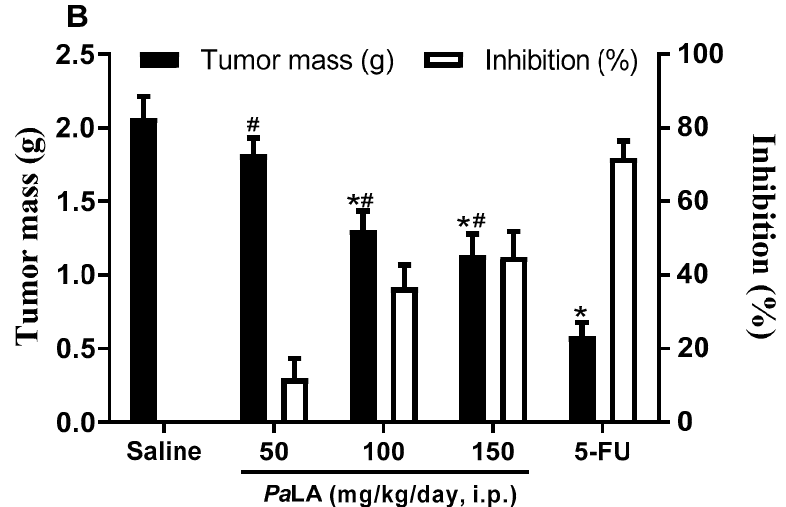
Figure 2. The e ff ect of Pa LE in mice inoculated with S180 cells. The graphs show the tumor mass in grams (g) and degree of growth inhibition (%). The animals were treated orally ( A ) and i.p. ( B ), starting one day after the tumor implantation, for 7 consecutive days. Saline was used as a negative control. 5-FU 25 mg / kg / day and Cyclophosphamide 15 mg / kg / day (cycle) were used as a positive control. Data are presented as mean ± standard error of the mean ( n = 7–10 animals / group) and the results evaluated by one-way analysis of variance (ANOVA) with a Student Newman Keuls post-test. * p < 0.05 compared to the saline group, # p < 0.05 compared to the 5-FU or Cyclo group. Water consumption, food, and body mass variation were the first parameters to monitor for a period of 8 days. The results obtained demonstrate that the groups of animals treated with Pa LE showed a reduction in body mass and food consumption, without altering water consumption